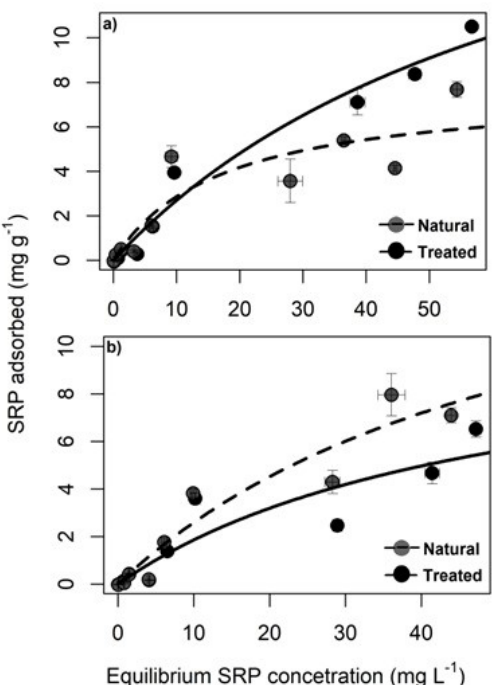
Figure 5. Langmuir adsorption isotherms for the natural adsorbents: (a) Planosol; (b) Luvisol, after the reduction of humic substances. SRP=Soluble Reactive